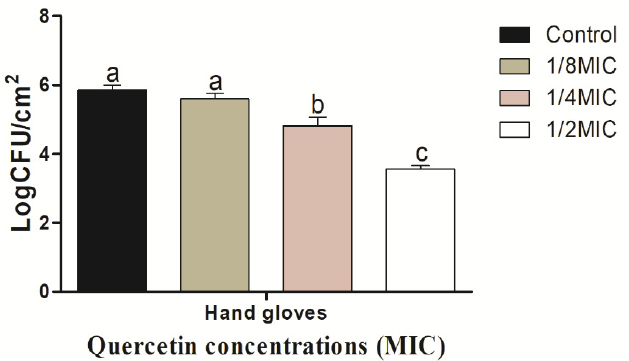
Figure 5. Inhibition of Vibrio parahaemolyticus biofilm formation (24 h) on hang gloves by sub-MICs of quercetin (µg/mL). Data are represented as mean ± SEM of three independent replicates. a–c Values with different letters differ significantly different by Duncan’s multiple-range test ( p < 0.05).